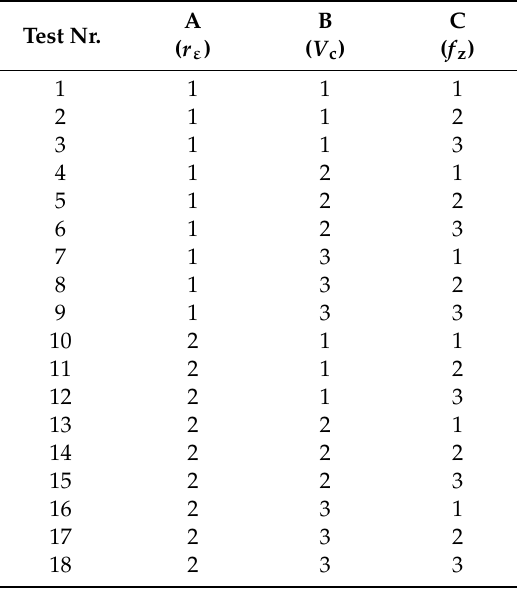
Table 5. The experimental design L 18 (2 1 × 3 2